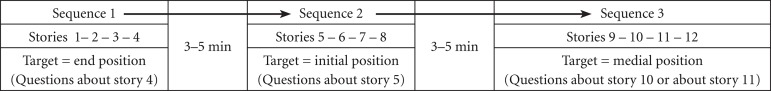
Scheme of stimulus presentation.